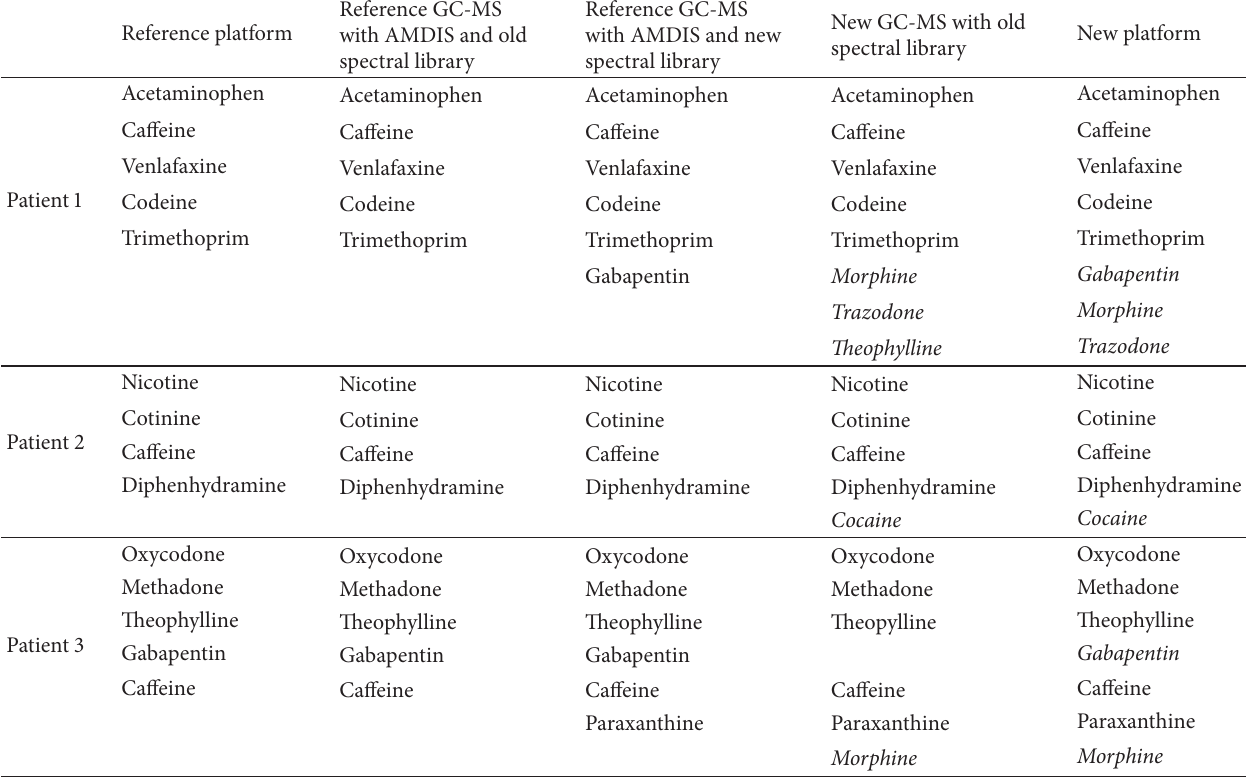
Table2:Listofdrugsidentifiedbythefiveplatformconfigurationsforthreepatientspecimens.Moredrugsweredetectedbythenewplatform compared to the reference platform and the mixed configurations.